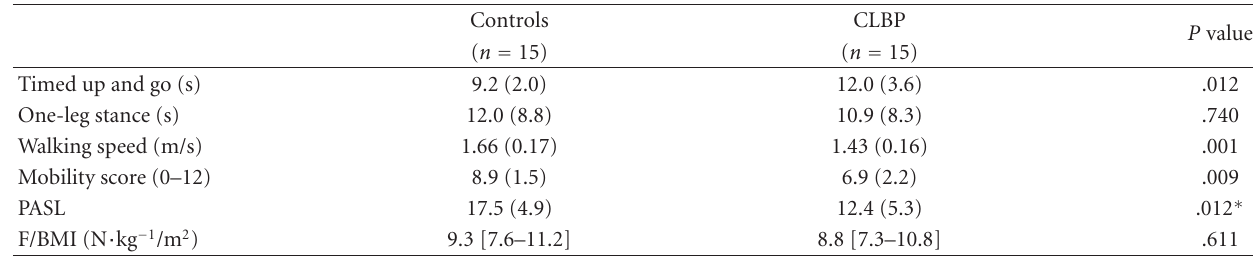
Table 2: Mobility functions and disuse-related variables.